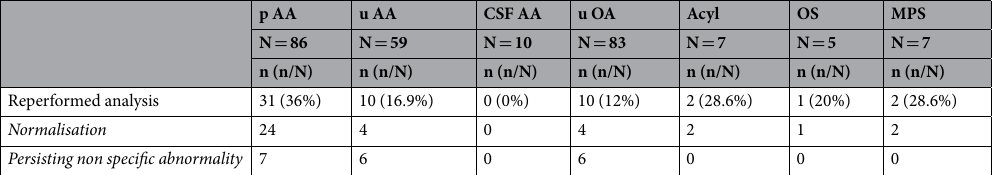
Table 7. Nonspecific metabolic abnormalities. pAA: plasma aminoacid chromatography; uAA: urine aminoacid chromatography; CSFAA: cerebrospinal fluid aminoacid chromatography; uOA: urine organic acid chromatography; ACYL: acylcarnitine profile; OS: urine oligosaccharides; MPS: urine